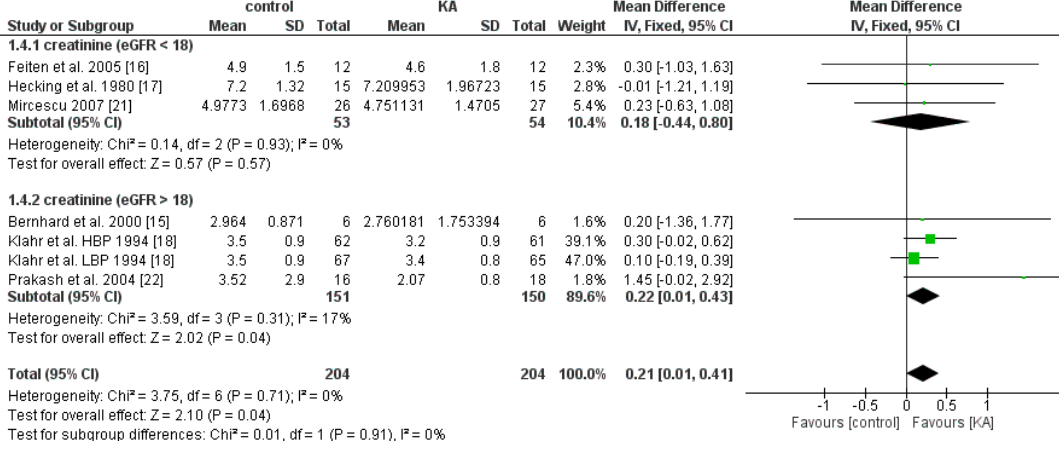
Figure 5. Forest plot of effects of KA on creatinine in CKD patients sub-grouped by eGFR. The fixed-effects model was utilized. Nutrients 2019 , 11 , x FOR PEER REVIEW